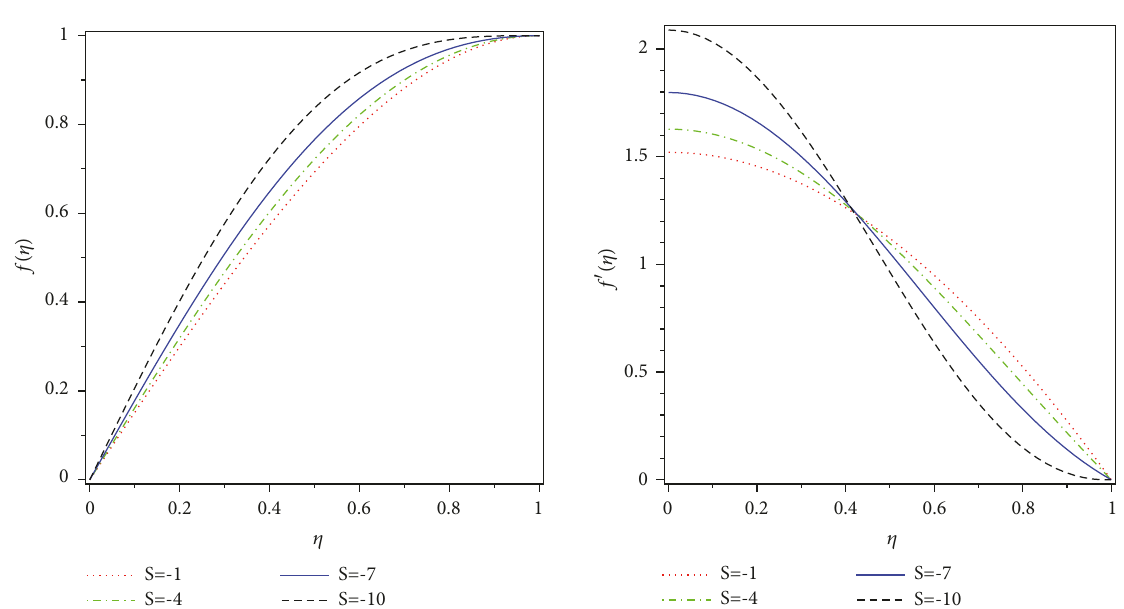
Figure 5: 𝑓(𝜂) and 𝑓 󸀠 (𝜂) for negative values 𝑆 when 𝑀 = 1 , 𝛾 = 0.4